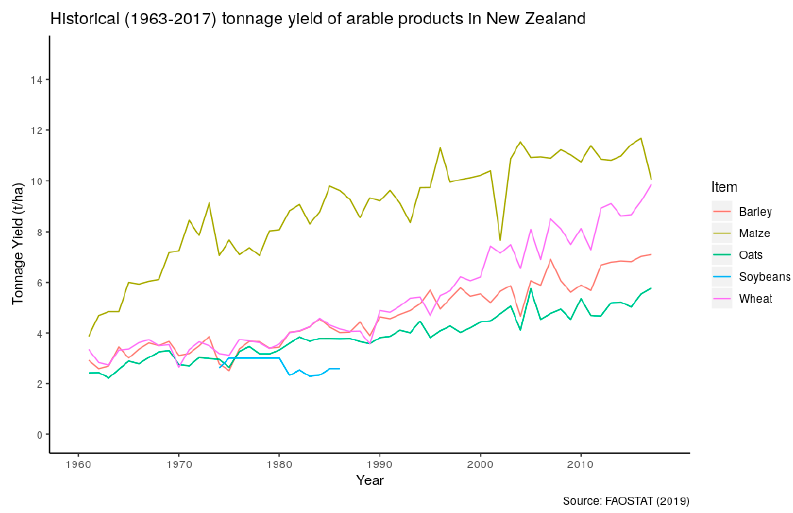
Figure 1. Historical (1963–2017) tonnage yield of arable products in New Zealand.